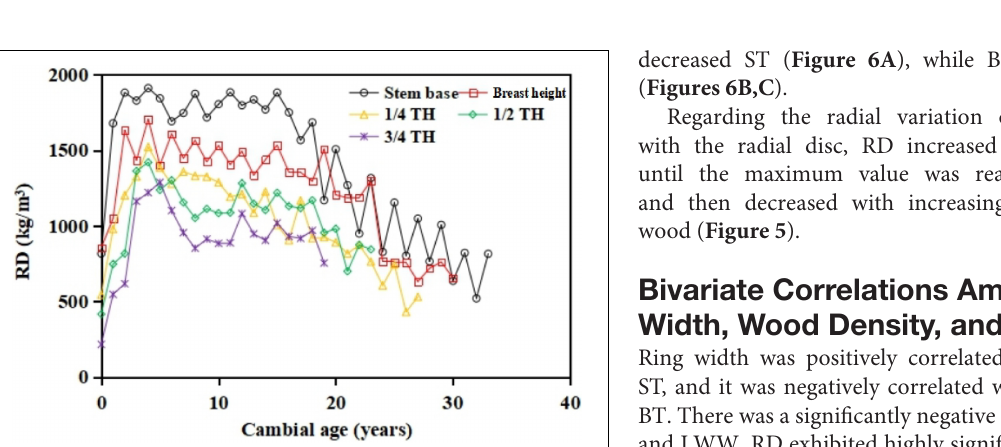
FIGURE 5 | Within-tree variation of ring density (RD) during the self-thinning of the even-aged pure S. tzumu stands. The different curves correspond to the different stem height